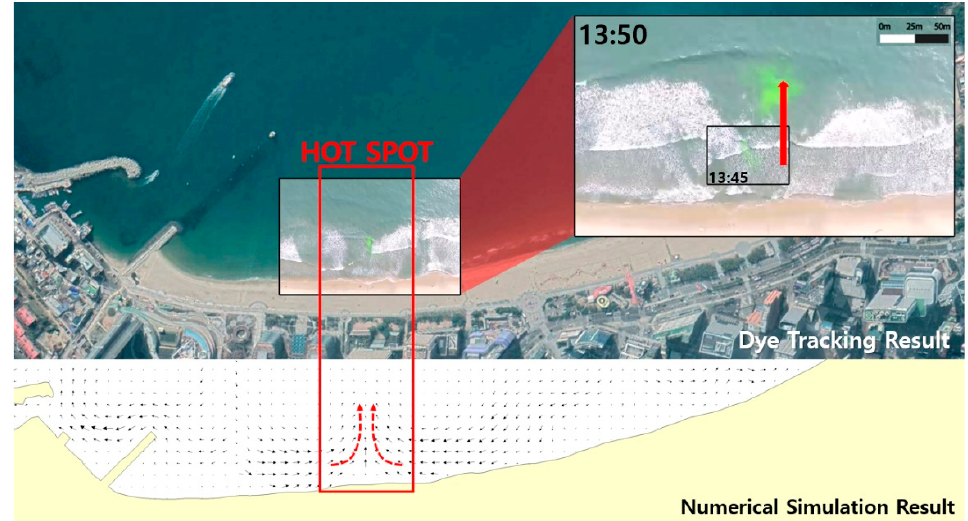
Figure 11. Rip current generation comparisons of numerical simulation result and dye tracking result (Numerical simulation October 14, 2019, 13:45, Dye tracking: 14 October 2019, 13:45–50).